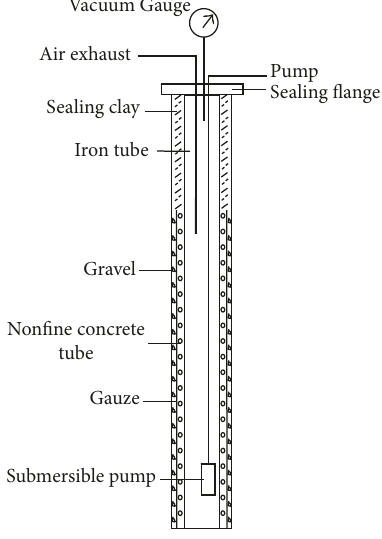
Figure 2: Diagram on vacuum tube dewatering method.